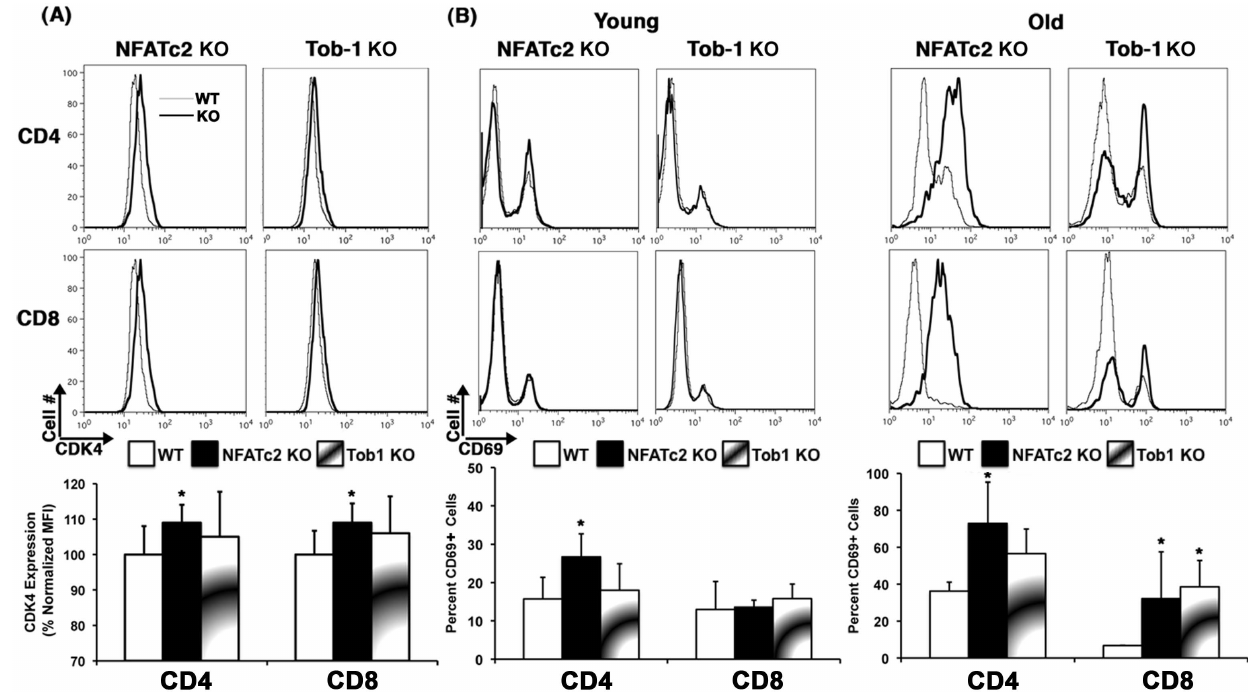
Figure 1. Nfatc2 and Tob1 KO mice have increased numbers of persistently activated cells invivo . Spleen and lymph node cells were isolated from age-matched WT, Nfatc2 KO, and Tob1 KO mice, and cells from each genotype and for each organ were pooled for experiments. Expression of CDK4 was measured by intracellular staining and expression of CD69 was measured by conventional cell surface staining of freshly isolated cells. (A). One-dimensional histograms (top) showing CDK4 expression, gated on CD4 and CD8 cells from representative Nfatc2 KO and Tob1 KO mice overlaid on WT controls as indicated. Dark lines in the histograms represent KOs and grey lines represent WT mice. Bar graphs (bottom) represent means 6 SD of the mean fluorescence intensity (MFI) for CDK4 expression in CD4 and CD8 cells. Data summarize 15, 12, and 5 experiments using triplicate samples of WT cells, Nfatc2 KO cells, Tob1 KO cells, respectively, each with pooled cells from 2 or 3 mice. MFIs among different experiments showed normal distribution. Asterisks denote values that are significantly different from WT (Student t-test p , 0.05). (B) One- dimensional histograms (top) showing CD69 expression, gated on CD4 and CD8 cells from representative young (left) and old (right) Nfatc2 KO and Tob1 KO mice overlaid on WT controls as indicated. Dark lines in the histograms represent KOs and grey lines represent WT mice. Bar graphs (bottom) represent means 6 SD percent CD69 + cells in the CD4 and CD8 compartments. Data for young and old mice summarize 10 and 4 experiments using triplicate samples of WT cells, 6 and 8 experiments using triplicate samples of Nfatc2 KO cells, and 4 and 3 experiments using triplicate samples of Tob1 KO cells, respectively. The percent of positive cells among different experiments showed normal distribution. Asterisks denote values that are significantly different from WT (Student t-test p ,